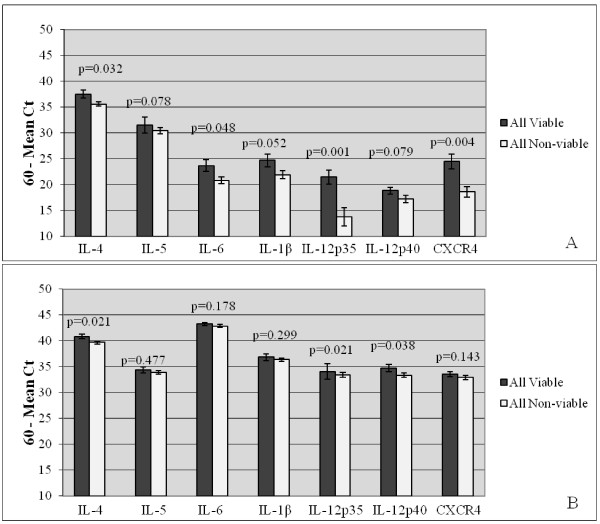
Relative Expression of Immunomodulators in Trophoblasts from Early-and Late-Term Feline Placentas from Viable and Non-viable Pregnancies. Real-time RT-PCR analysis of trophoblast expression of the pro-inflammatory cytokines (IL-6, IL-1β, IL-12p35, and IL-12p40), the anti-inflammatory cytokines (IL-4 and IL-5), and the chemokine receptor (CXCR4) in early-(A) and late-term (B) placentas from all viable (n = 4 each for early and late tissues) versus all non-viable (n = 4 each for early and late tissues) pregnancies. Bars represent mean Ct values substracted from a negative endpoint (60-mean Ct), bracketed by standard errors of the mean. P values obtained from Wilcoxon rank sum test are noted. P values ≤ 0.05 were considered significant.